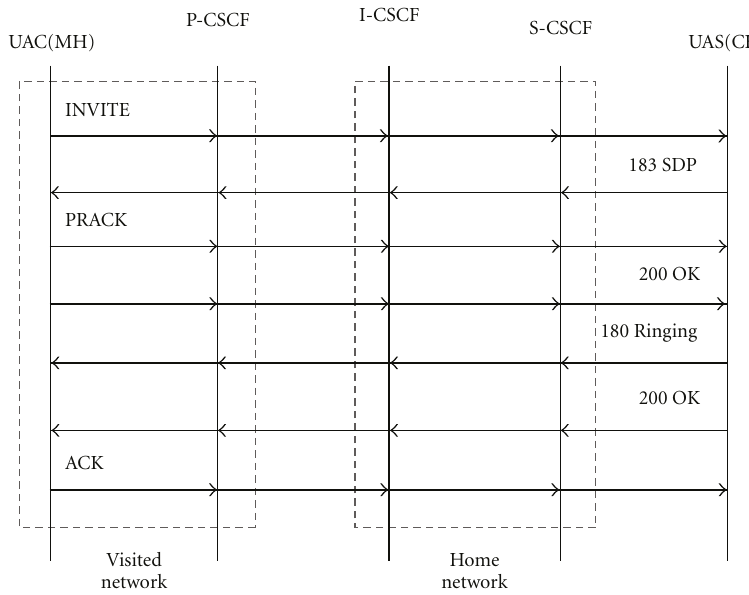
Figure 1: SIP message exchange for reestablishing the connection between MH and